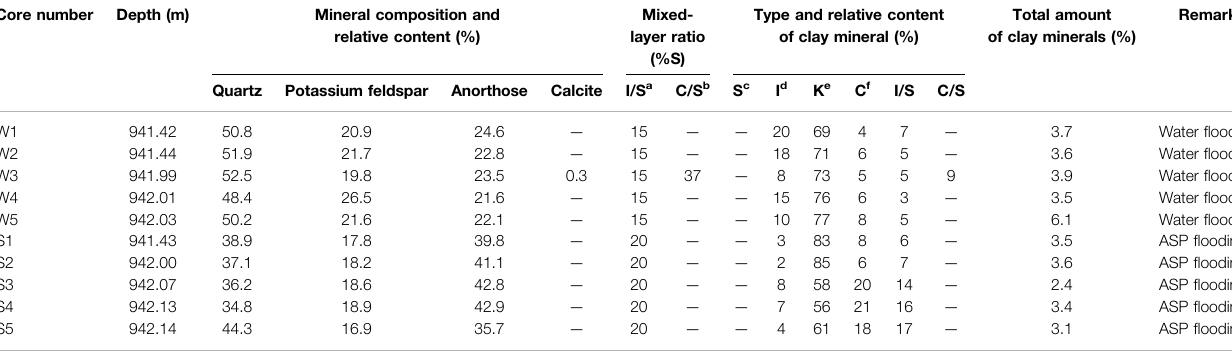
TABLE 1 | Variation of rock mineral composition and content before and after ASP fl ooding. Core number Depth (m) Mineral composition and